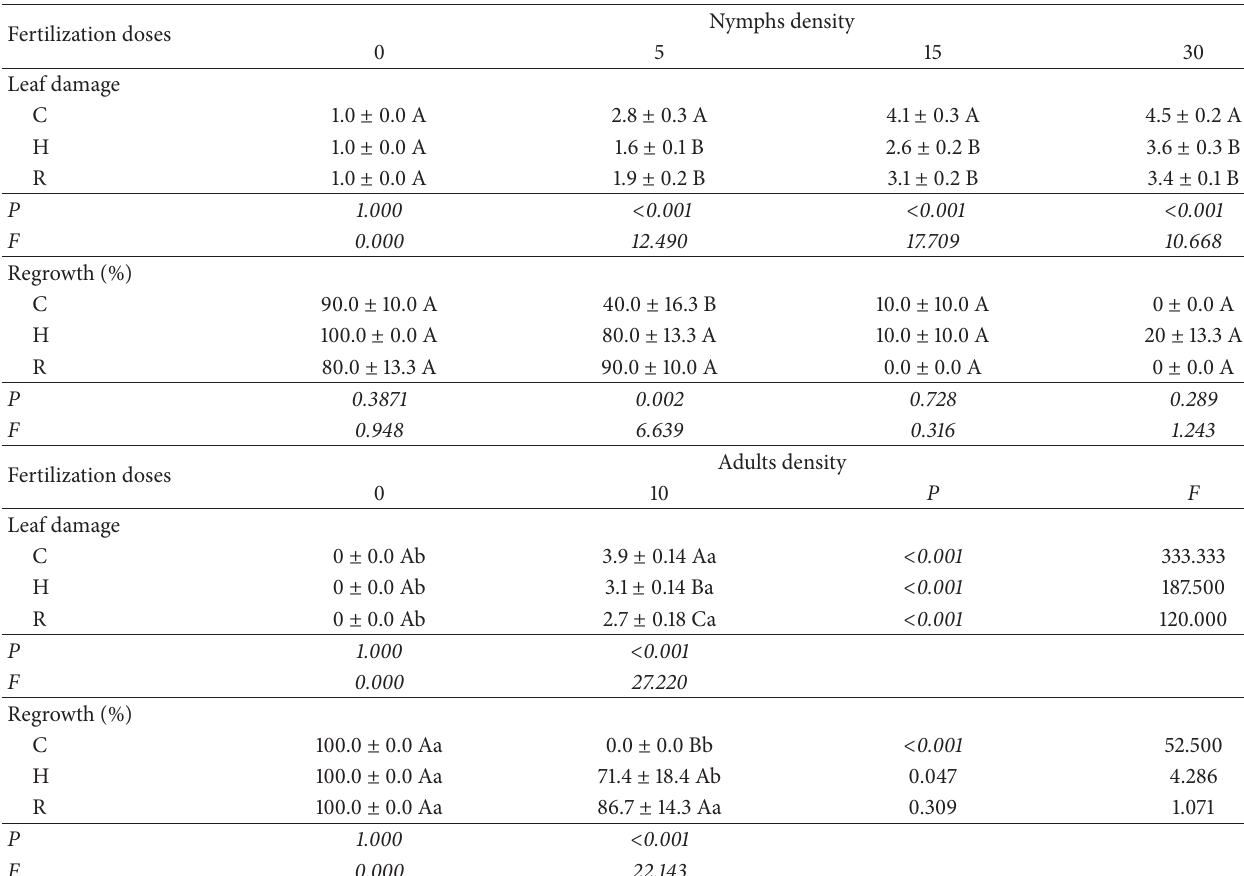
Table 1: Leaf damage (damage score) and regrowth (%) of Brachiaria ruziziensis cultivated under recommended (R), half of recommended (H), and control (C) fertilization and exposed to different Mahanarva spectabilis nymphs and adults